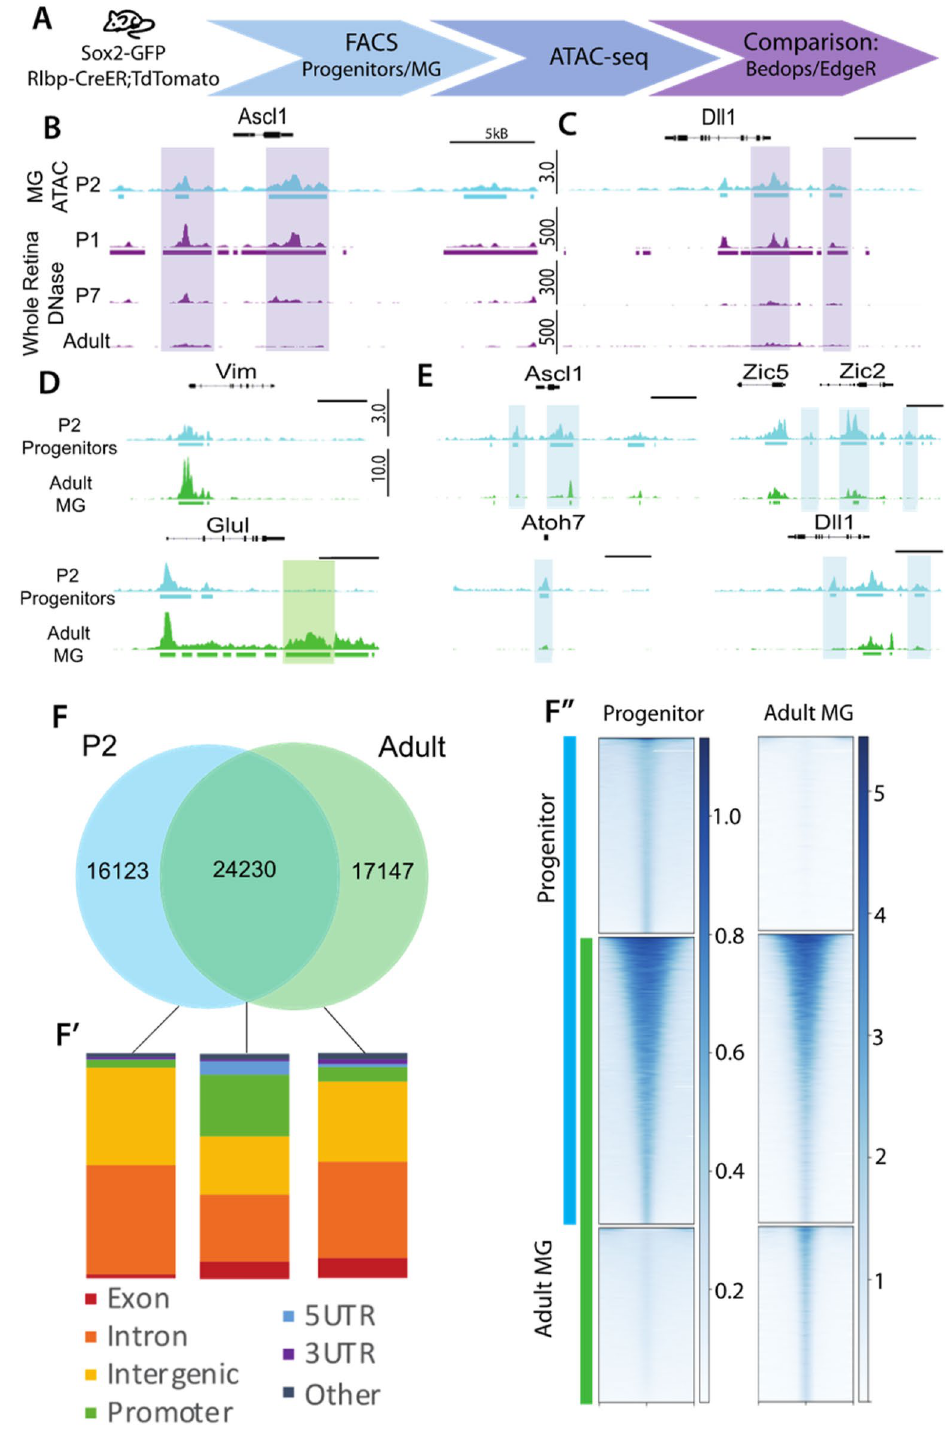
Figure 1. Progenitor and Müller Glial accessibility is generally similar. ( A ) ATAC experimental design. ( B , C ). Genomic tracks of P2 progenitor ATAC and whole retina DNase 13 around Ascl1 and Dll1. Purple bars represent regions of similar accessibility between P1/2 samples. ( D ). Tracks for progenitors and adult MG 9 ATAC-seq at glial genes and E. progenitor genes. Shaded bars represent regions of interest. Scale bar ( B – E ) 5 kb, track heights labeled to the side of tracks (DNase: FKPM, ATAC: reads per million, all heights consistent per sample). F. BEDOPS overlaps of progenitor and adult MG ATAC-seq peak calls. F’. Genomic region annotation of accessibility profiles in F. Annotation values compared via Chi squared test (Shared regions promoter, posthoc p val < 1*10 –250 ; intergenic posthoc p val = 1.46*10 –185 [MG], 5.99*10 –37 [Progenitors]; intronic 1.78*10 –196 [MG], 3.84*10 –12 [Progenitors]). F’’. Read density (RPKM) of ATAC-seq in progenitor and adult MG ATAC at accessibility profiles from